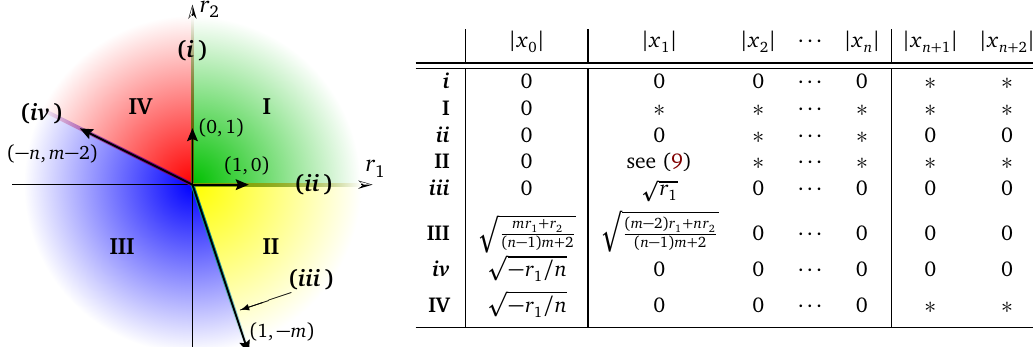
Figure 1: The phase diagram of the GLSM with the Calabi-Yau n -fold ⊂ (cid:70) ( n ) the “ ∗ ” entries are generally nonzero and are outside the Stanley-Reisner